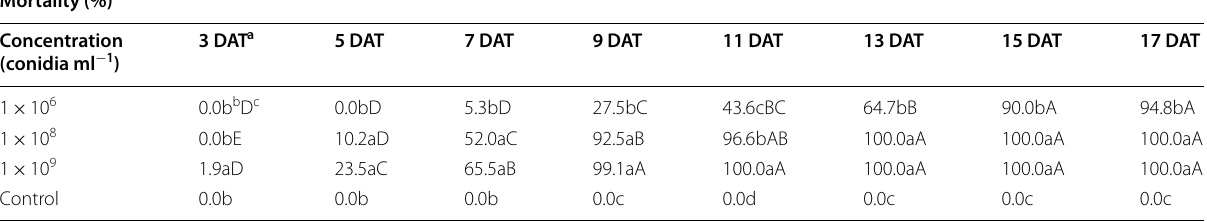
a DAT: Days after treatment b Means in a column followed by the same letter are not statistical significantly different (ANOVA P < 0.05, Tukey’s test) c Means in a line followed by the same capital letter are not statistical significantly different (ANOVA P < 0.05, Tukey’s test) Table 6 Mortality of Tropinota hirta exposed to HP3-1 isolate Mortality (%)